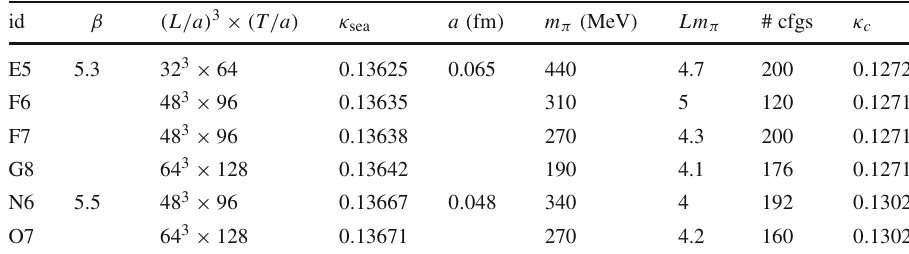
Table 1 Parameters of the simulations: bare coupling β = 6 / g 2 , lattice resolution, 0 hopping parameter κ , lattice spacing a in physical units, pion mass, number of gauge configurations and bare charm quark